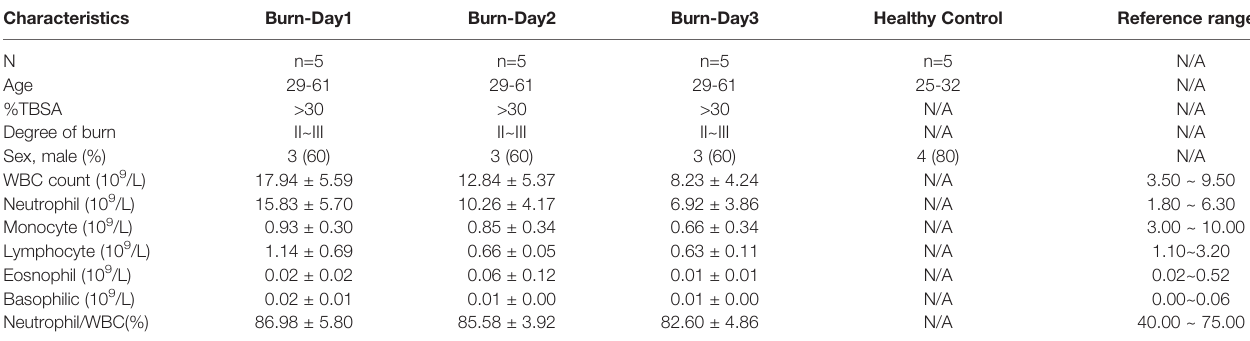
TABLE 2 | Characteristics of healthy controls and patients with burn injuries. Characteristics